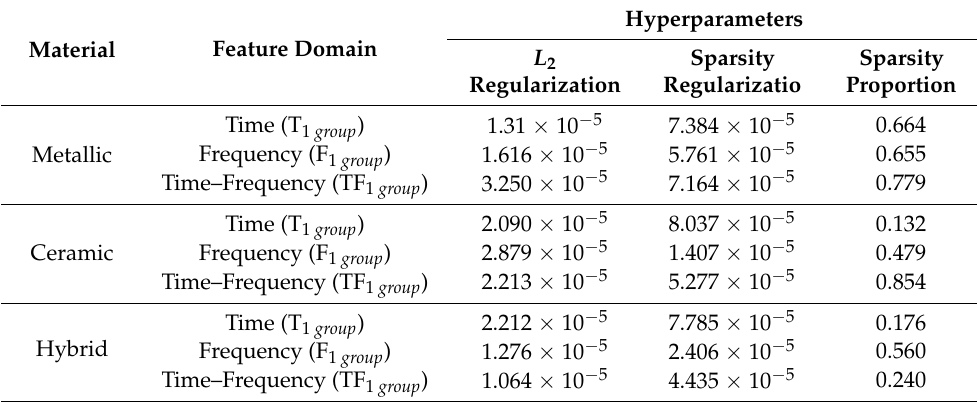
Table 4. Parameters tuned by the GA for each SAE structure that is considered for each domain of analysis for the vibration signals used in the stacked AE; all technology